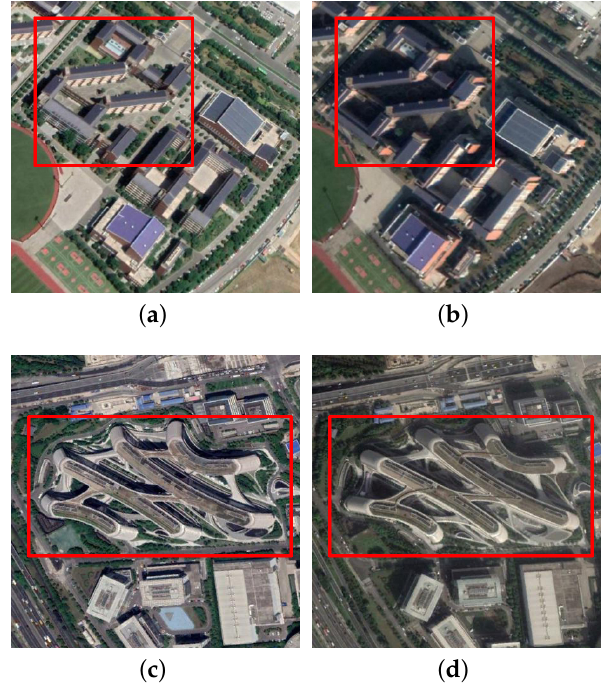
Figure 2. Bitemporal Google Earth images. ( a ) Taken in 2019 in Nanjing, China. ( b ) Taken in 2018 in Nanjing, China. ( c ) Taken in 2019 in Shanghai, China. ( d ) Taken in 2018 in Shanghai, China. In Figure 3, the 4 × 4 receptive field in the blue feature layer is mapped to the 2 × 2 parameter in